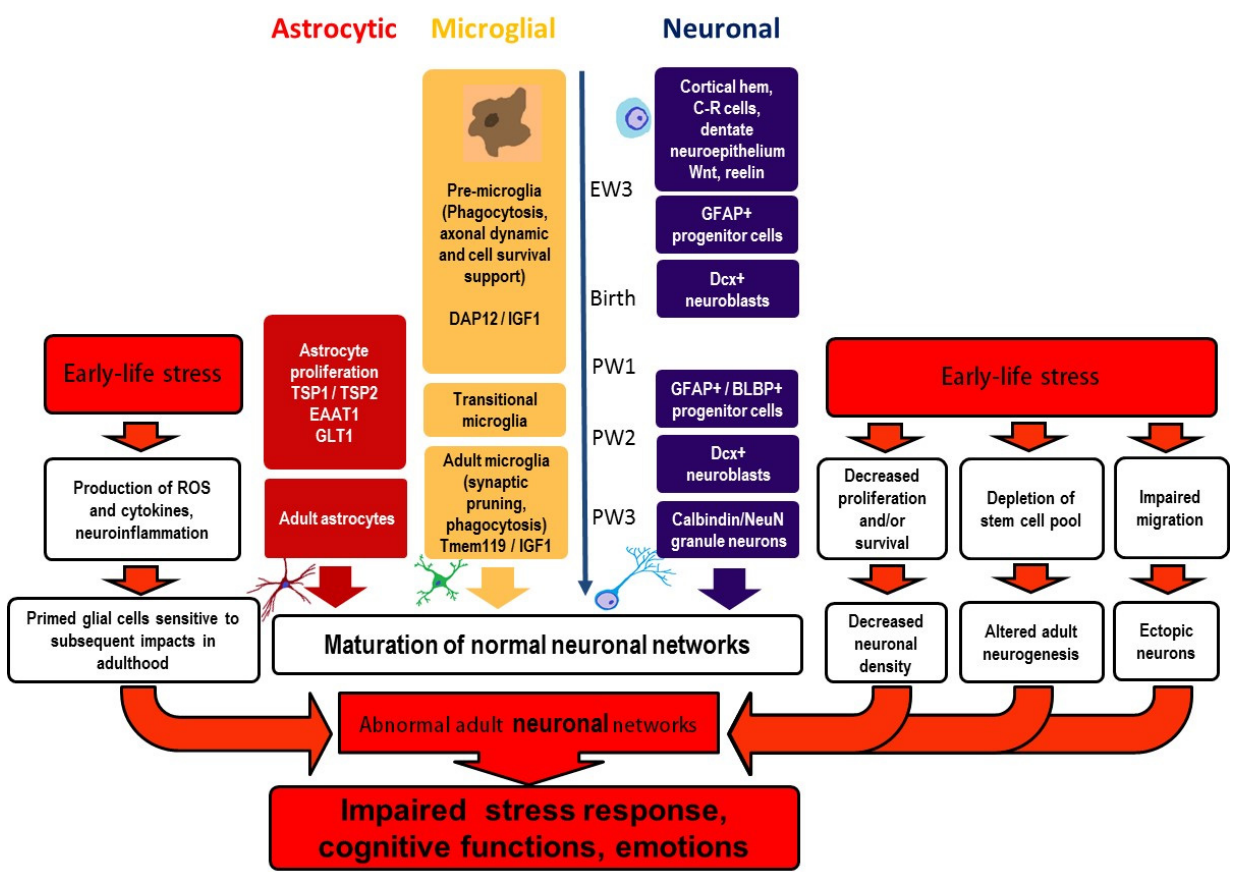
Figure 1. Maturation of neurons and glial cells in the dentate gyrus and effects of early life stress. Early life stress interferes with maturation of both neurons and glia in the DG, resulting in the development of abnormal neural networks in adulthood. These aberrant networks form the basis for perturbed stress response and the development of brain pathologies (cognitive and emotional disturbances), their manifest being potentiated by stressful experiences in later life. BLBP—basic lipid ‐